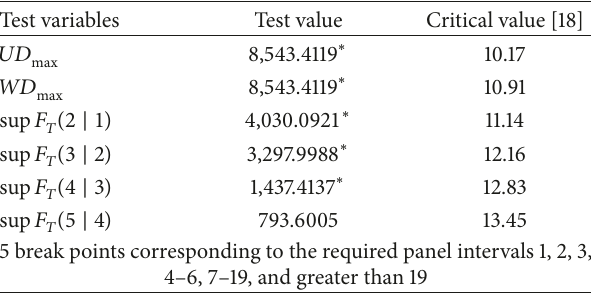
Table 3: Significance test of break